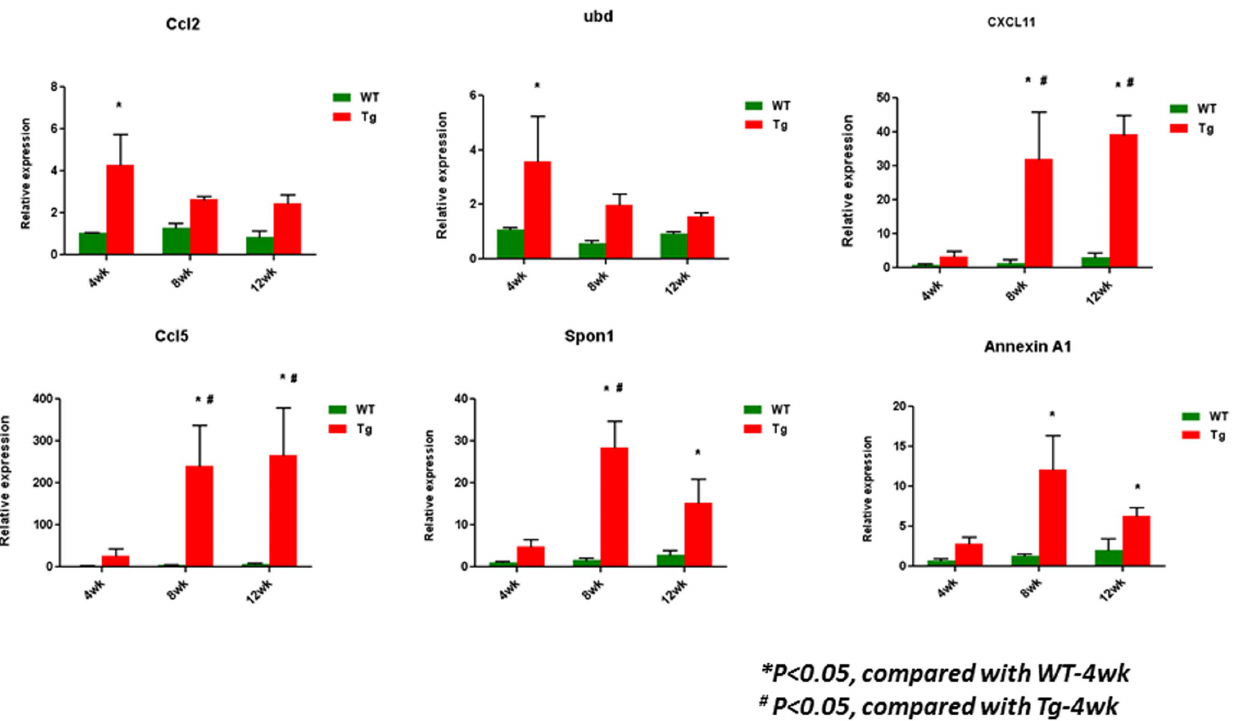
Figure 12. Validation of the selected genes from those up-regulated at all three time points by real-time PCR in kidney cortices of these mice. *P , 0.05, compared with WT-4wk; # P , 0.05, compared with Tg-4wk; n=3.